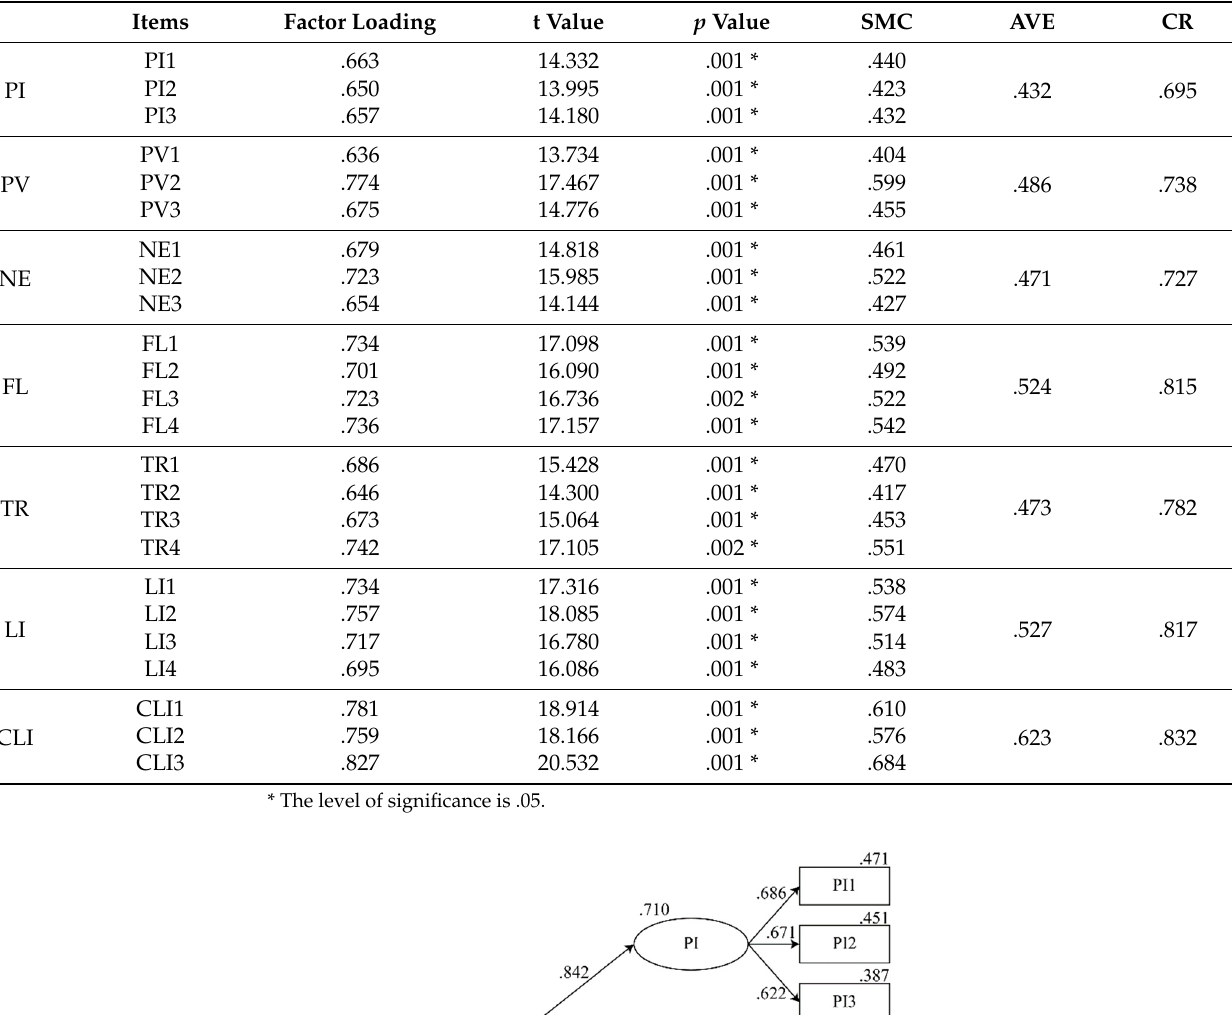
Table 6. Results of the convergent validity test.